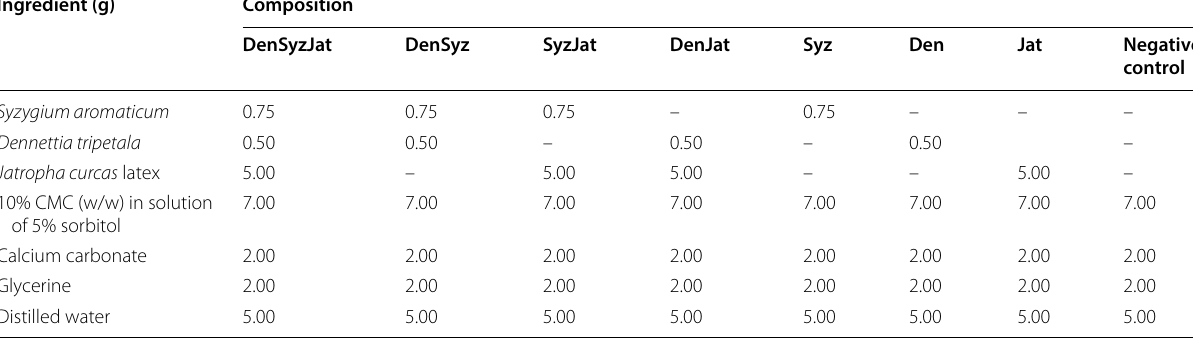
Table 1 Composition of formulated toothpaste